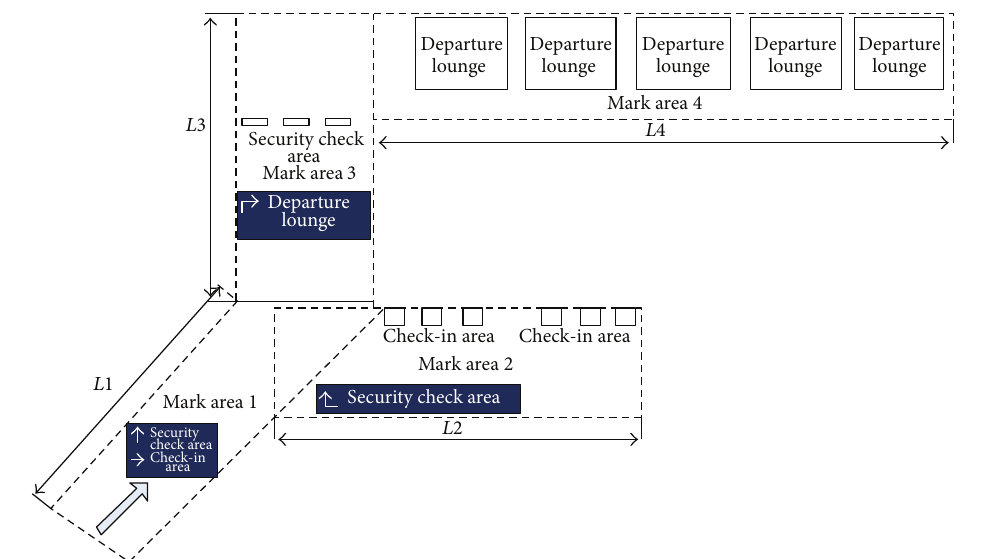
Figure 15: Chart of transportation facilities inside the terminal.